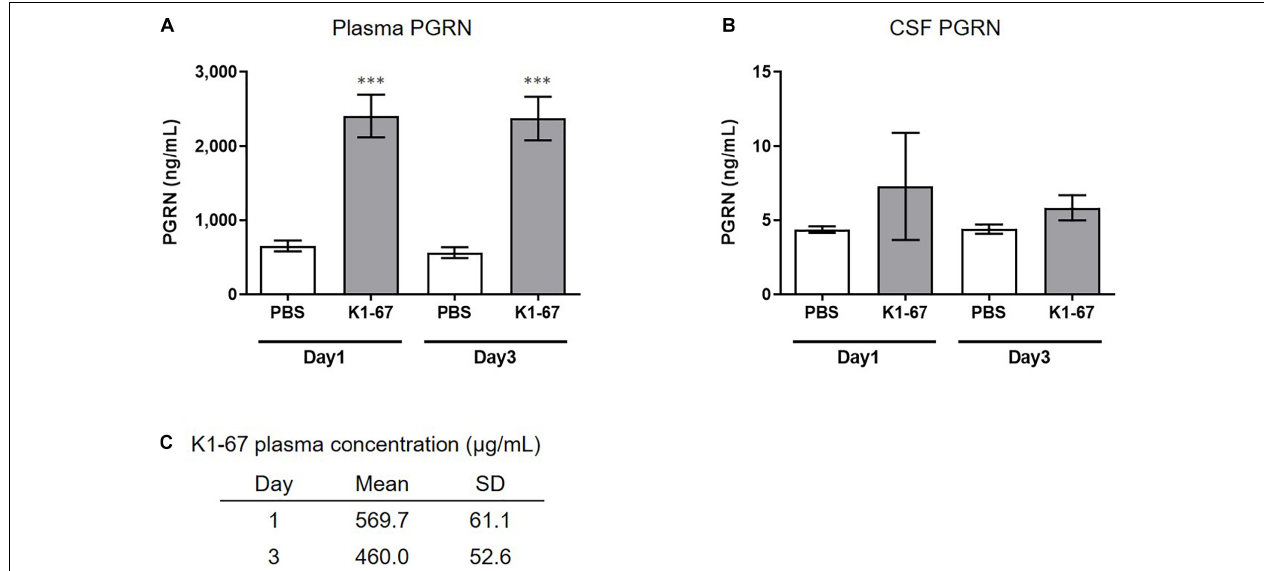
FIGURE 3 | Up-regulation of plasma or CSF PGRN levels in K1-67-treated mice. (A,B) Plasma or CSF PGRN levels in response to K1-67. Mouse plasma or CSF was collected 1- or 3-days after the treatment of K1-67 at 100 mg/kg, i.v., and subjected to ELISA. Pooled CSF from 4 mouse was used due to the small volume of CSF from individual mouse. The vertical axis indicates PGRN concentration. Data are mean ± SD from 12 or 3–4 independent experiments for plasma and CSF, respectively. ∗∗∗ p < 0.001 vs. PBS-treated group by Aspin–Welch t -test. (C) K1-67 concentration in plasma. Mouse plasma was collected 1 or 3 days after the treatment of K1-67 at 100 mg/kg, i.v., and subjected to liquid chromatography-mass spectrometry. Data are mean ± SD from 3 independent